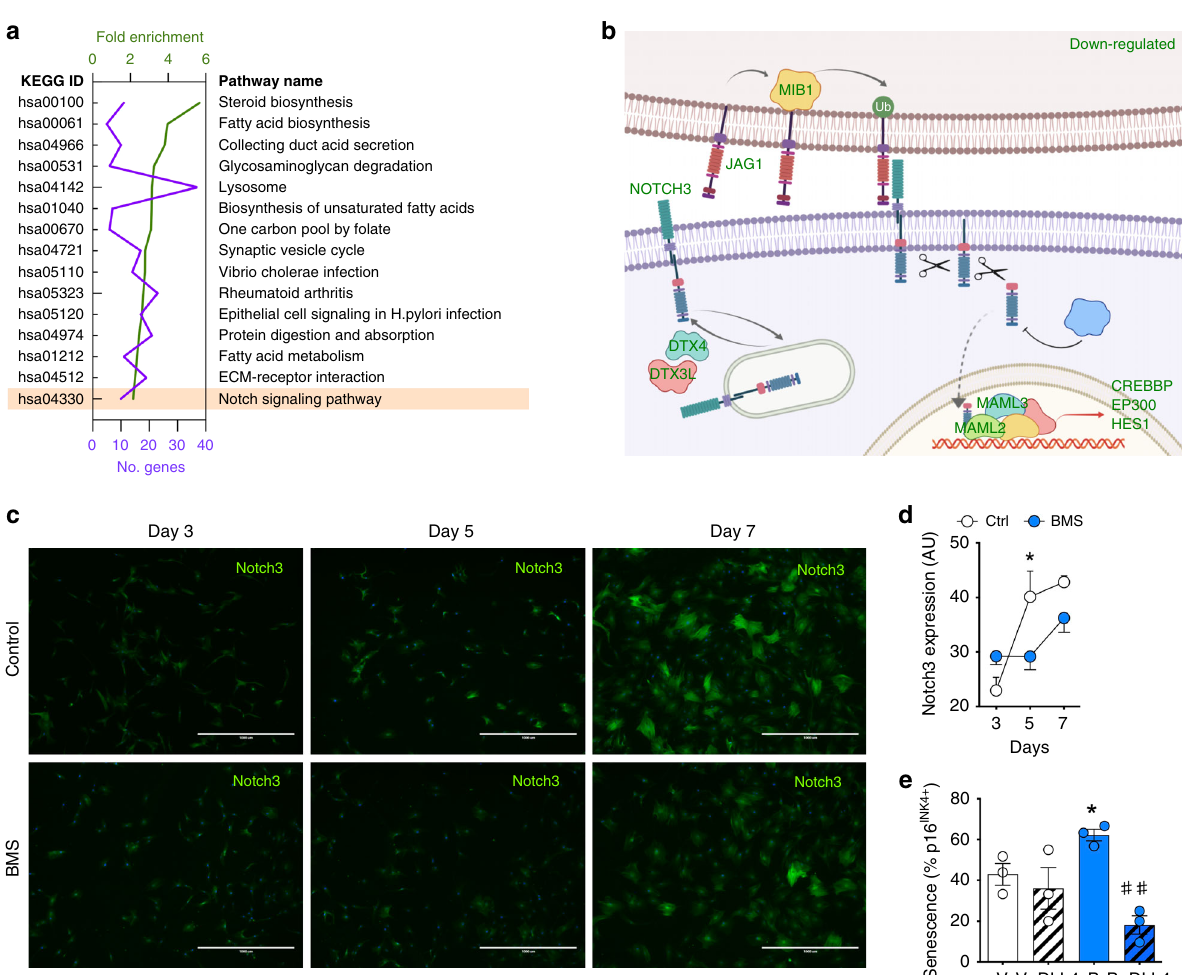
Fig. 4 Role of the Notch pathway in SF senescence induced by BMS. a Analysis of KEGG pathways of all 1952 differentially expressed genes following treatment with BMS (1 µ M; 7 days). Number of genes annotated to each pathway (purple) and fold enrichment (green) are shown for the top 15 pathways. The Notch pathway is highlighted. b Speci fi c members of the Notch pathway down-regulated in BMS-treated SF (green); fi gure was created using BioRender. Additional genes are shown in Supplementary Table 3. c Visual expression of Notch3 protein as determined by immuno fl uorescence on SF with or without treatment with BMS (1 µ M; 7 days). Scale bars indicate 1000 μ m. d Quanti fi cation of Notch3 protein expression on SF with or without treatment with BMS (1 µ M for 7 days; n = 3, one-way ANOVA vs. control, Ctrl; * p < 0.05). e SFs were treated with vehicle or 1 μ M BMS, in the presence or absence of the recombinant Notch ligand DLL4 (5 μ g/ml) for 7 days. Senescence was measured by p16 INK4 staining by immuno fl uorescence and % of positive cells were quanti fi ed ( n = 3, Student ’ s t -test compared to vehicle (V*) or to BMS (B # ); * p < 0.05, ## p < 0.001). Source data are provided as Source Data fi